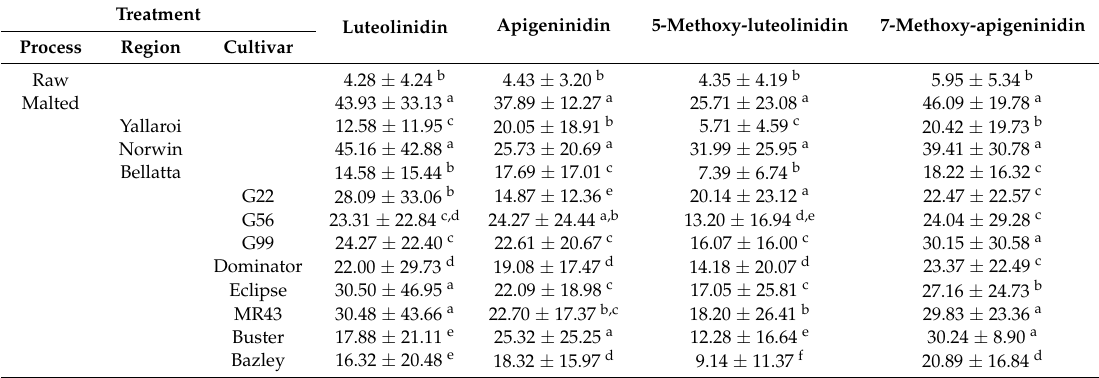
Means with the same letter in a column are not significantly different ( p >